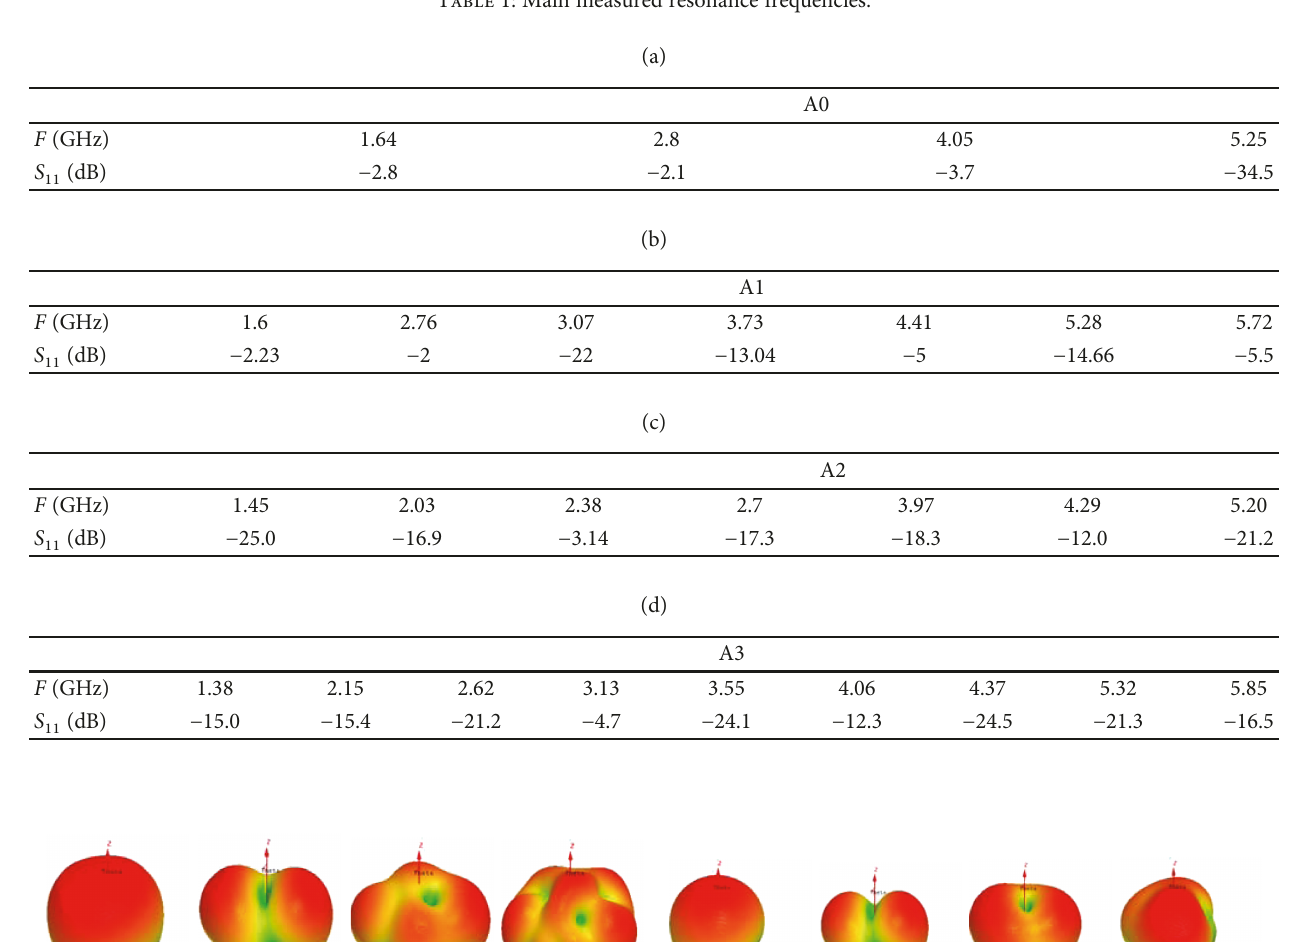
Table 1: Main measured resonance frequencies.